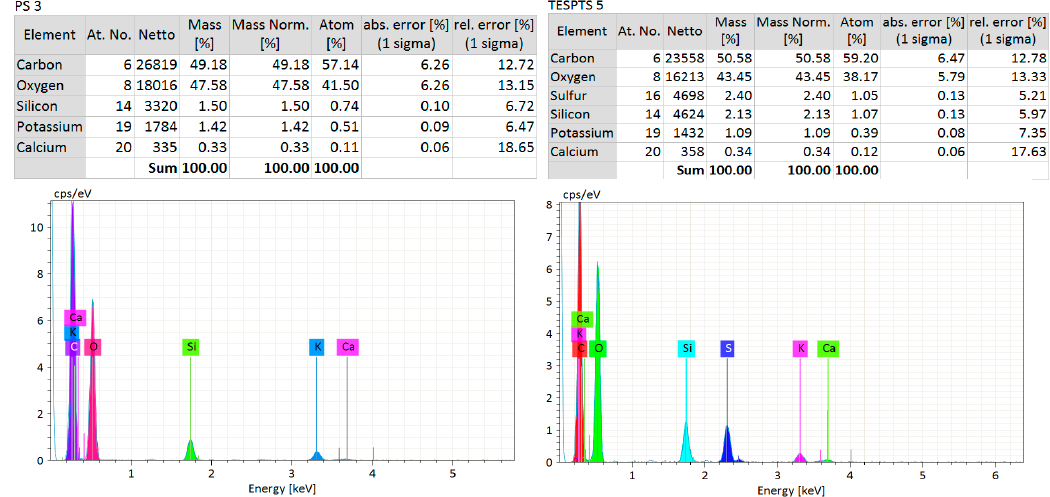
Figure 8. Elementary characteristic of pure straw and TESPTS straw.